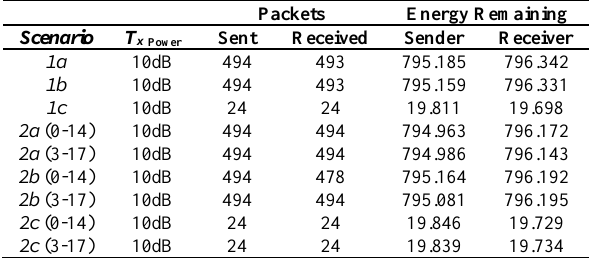
Table 23. Packets and Remaining Energy at -2